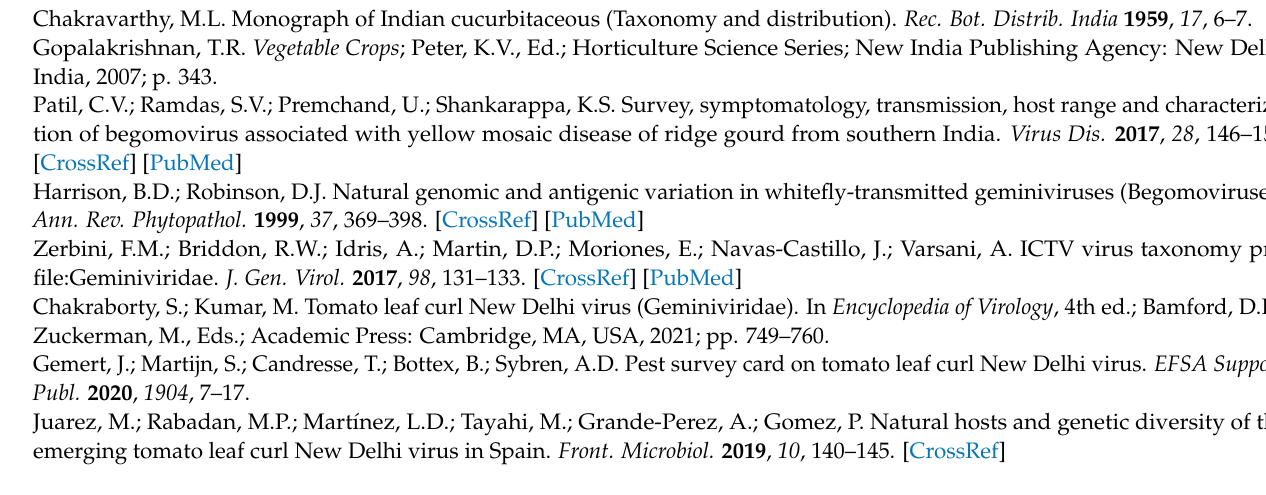
the reaction of samples from different hosts using ToLCNDV-Rg-CP-Pab; Table S5. Validation of DAC-ELISA by detection of ToLCNDV in plant samplescollected from various fields in South India; Table S6. Primers used in the present study for amplification of ToLCNDV coat protein gene; Table S7. GenBank accession numbers of selected begomovirus sequences from database used in this study for analysis of DNA-A component and coat protein; Figure S1. Agarose gel photograph showing restriction digestion of recombinant pBluescript IIKS(+)-ToLCNDV-Rg isolate-CP with BamH I and Hind III restriction endonucleases (a) and Restriction digestion of recombinant pET22-NH-ToLCNDV- Rg-CP with Nde I and Hind III restriction endonucleases (b); Figure S2. Expression of ToLCNDV-Rg-CP in E. coli at different concentrations of IPTG and incubation temperatures; Figure S3. Dot immuno binding assay (DIBA) with different dilutions of ToLCNDV-Rg-CP-Pab tested with ToLCNDV-Rg-CP; Figure S4. Agarose gel showing PCR amplification of core CP of begomoviruses from various infected host plants; Figure S5. LAMP amplification of begomoviruses from various crops suspected to be infected with begomovirus and its visualization on (a) 2 % agarose gel (b), EtBr and (c) VeriPCR